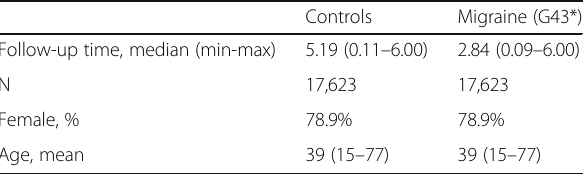
Table 1 Baseline characteristics of the migraine patients and